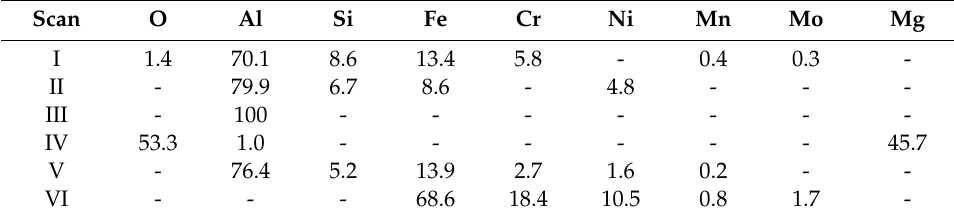
Table 8. Results of EDS scans indicated by arrows in Figure 8 (in at %).